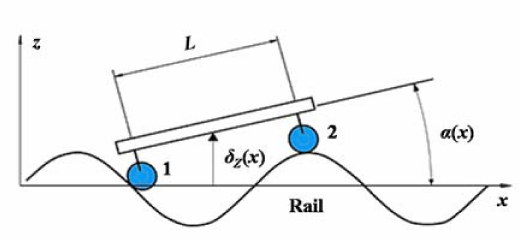
Figure 2. Stage-rails